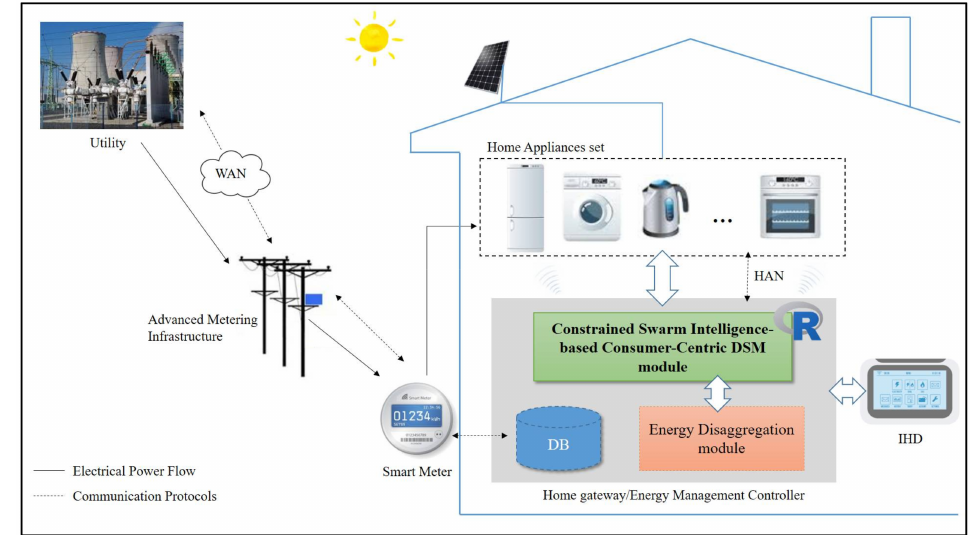
Figure 1. Schematic Diagram of the residential consumer-centric DSM model enabling utilities and consumers to operate their energy management